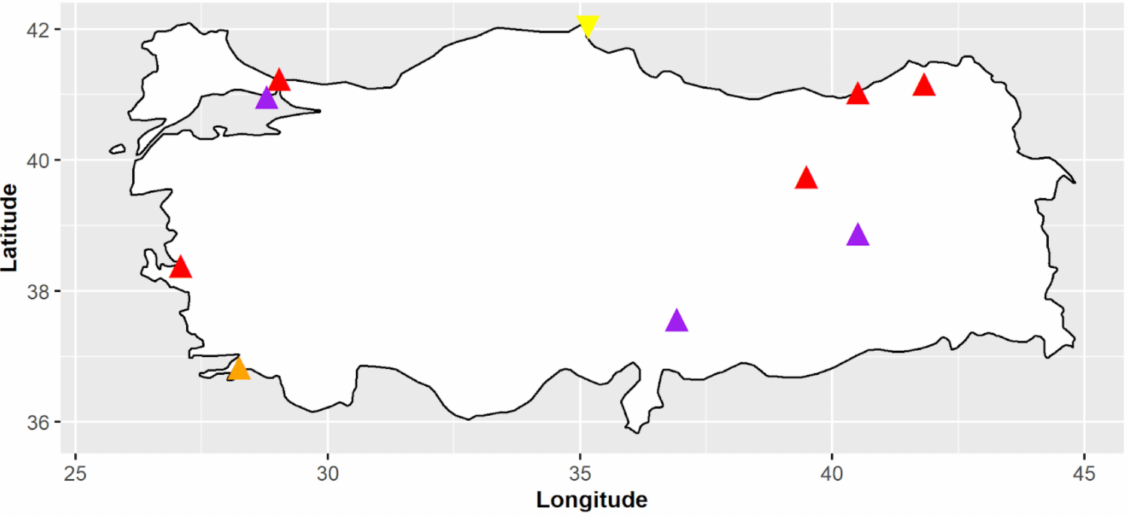
Figure A13. Mann-Kendall trend results of TCI values for December (Red upper triangle denotes increasing trend at the 10% significance level, purple upper triangle denotes increasing trend at the 5% significance level, brown upper triangle denotes increasing trend at the 1% significance level, yellow lower triangle denotes decreasing trend at the 10% significance level, green lower triangle denotes decreasing trend at the 5% significance level and blue lower triangle denotes decreasing trend at the 1% significance